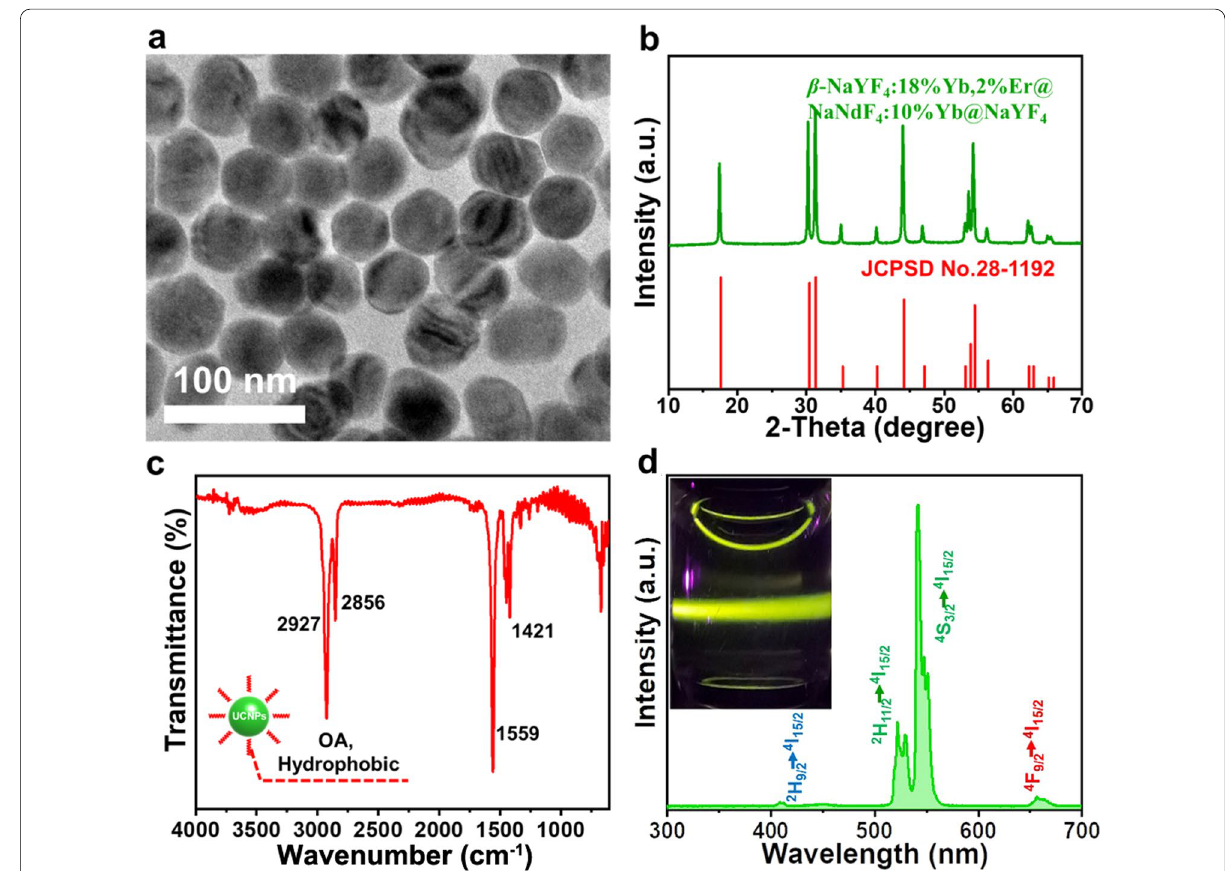
Fig. 1 TEM image ( a ), powder X-ray diffraction pattern ( b ), ATR-FTIR spectrum ( c ), and upconversion emission spectrum ( d , hexane) of